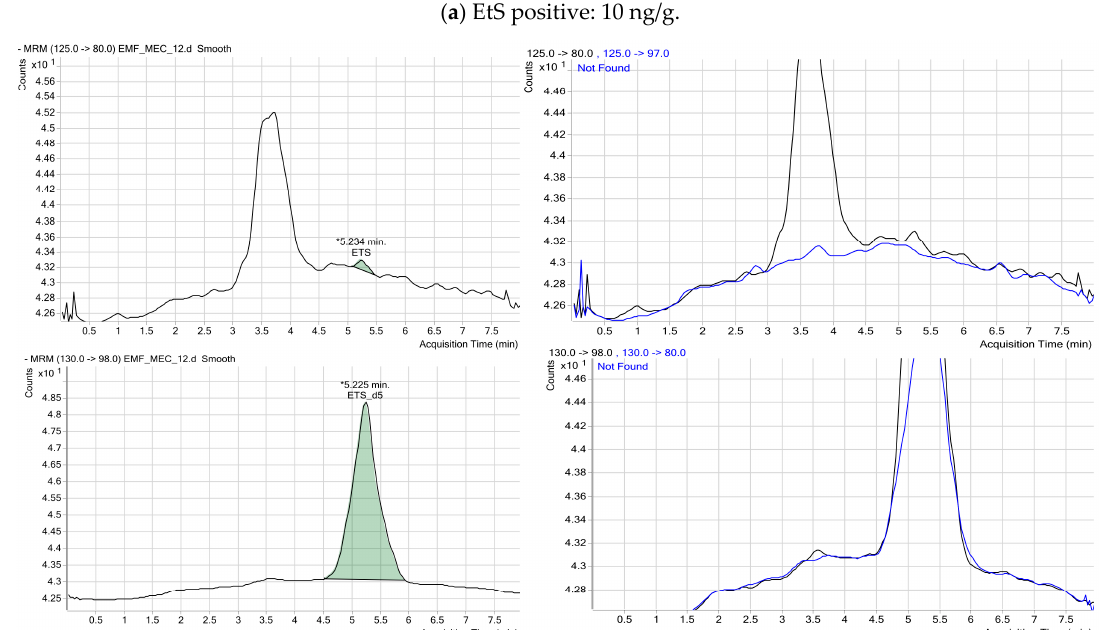
Table 1. Prevalence of substance use during pregnancy according to clinical data of parturient women and markers of fetal alcohol exposure. Clinical Information of Parturient Women